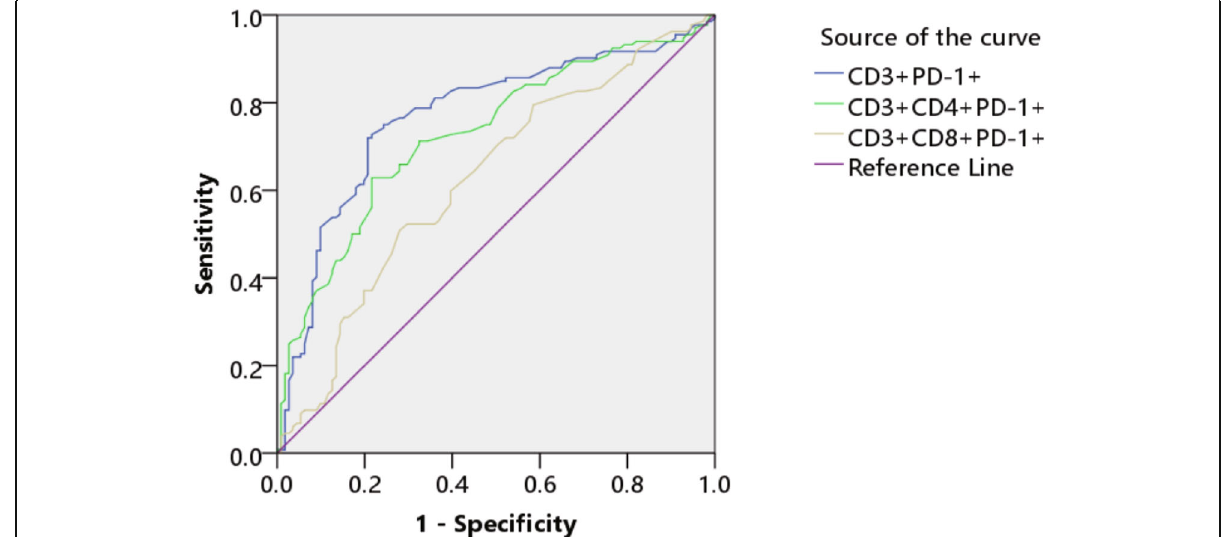
Fig. 8 The ROC curve of CD3 + PD-1+, CD3 + CD4 + PD-1+ and CD3 + CD8 + PD-1